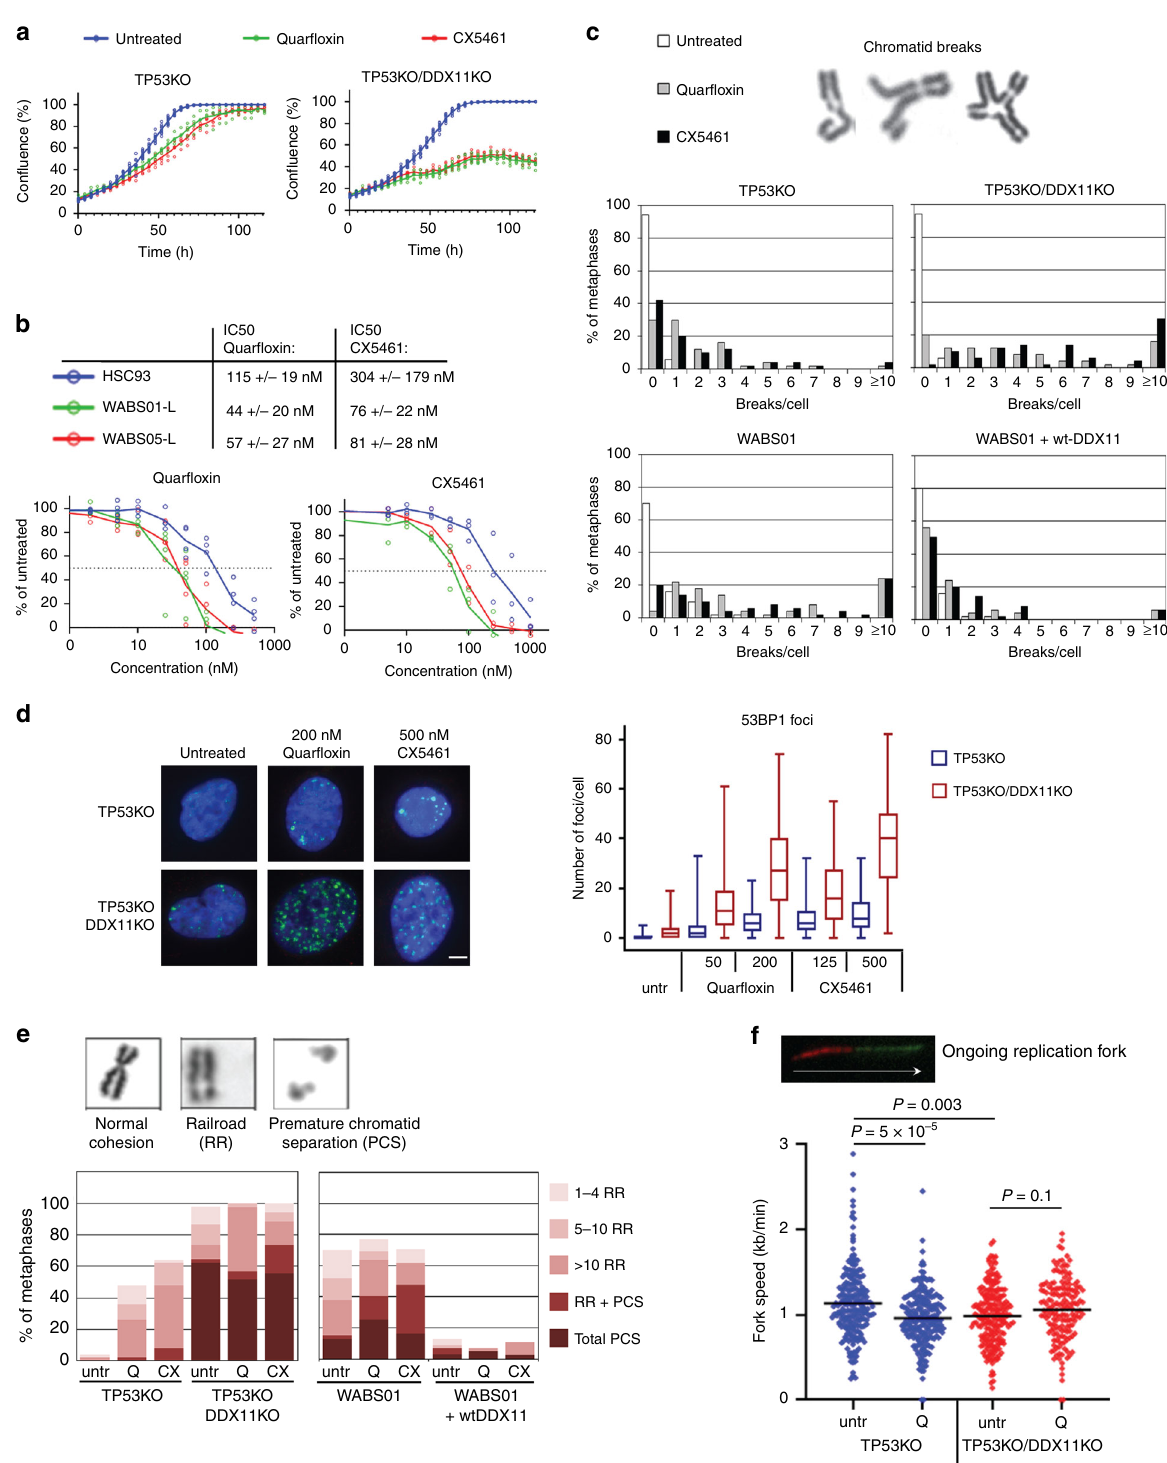
foci (Fig. 6d). Strikingly, G4 stabilization was suf fi cient to induce cohesion loss in RPE1 cells and aggravated cohesion defects in WABS cells (Fig. 6e). WABS01 + wtDDX11 cells did not show cohesion loss upon G4 stabilization, suggesting that over- expression of DDX11 confers cellular resistance to these com- pounds. Lastly, we assessed replication fork dynamics by a DNA fi ber assay. Quar fl oxin had no clear effect on origin fi ring (Sup- plementary Fig. 9a), but we observed reduced fork speed (Fig.